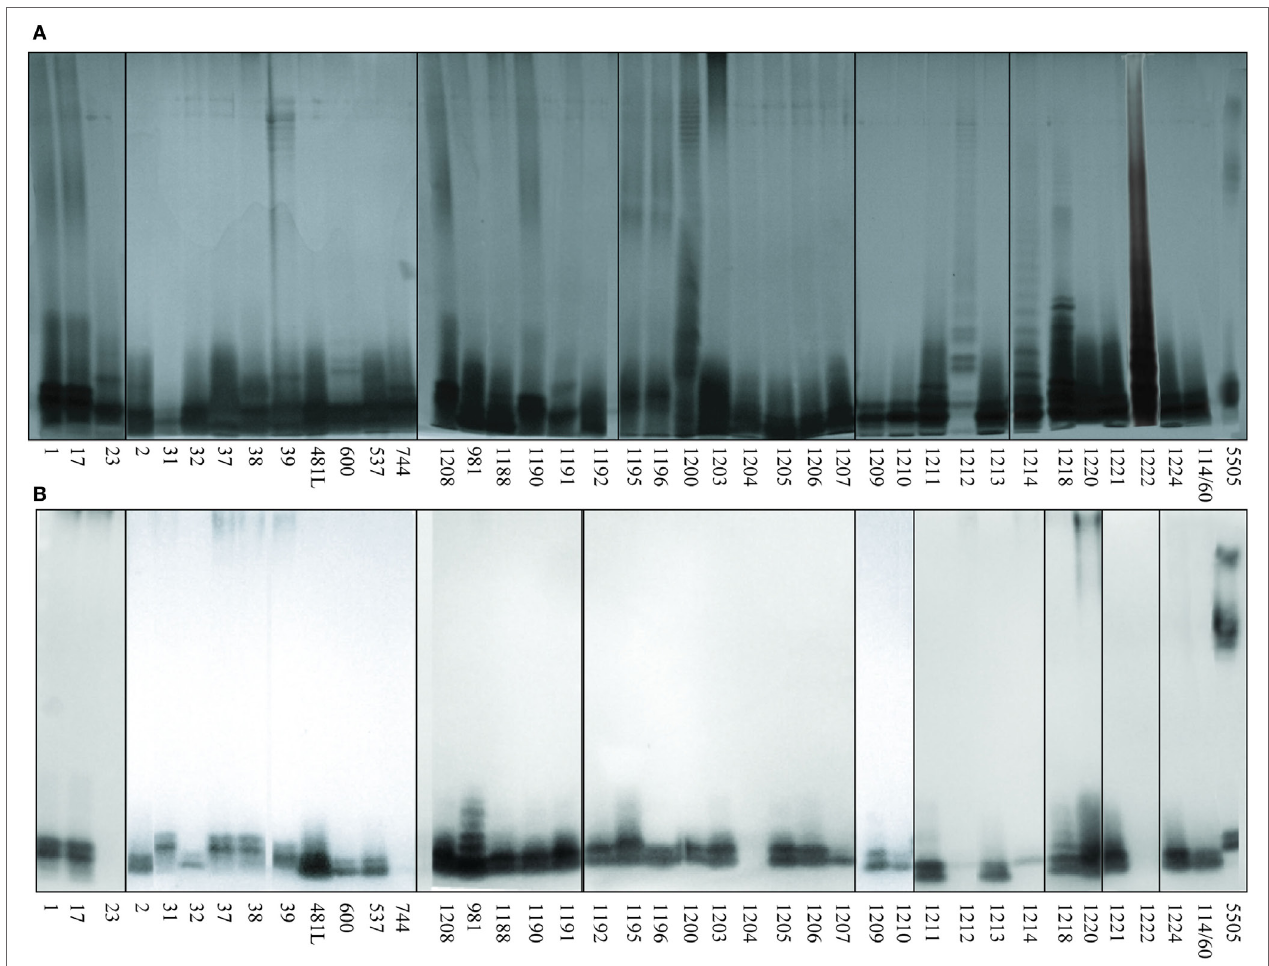
FigUre 2 | Silver stained SDS-PAGE (a) and lectin blotting analysis (B) of the interaction of human MBL (hMBL) with Hafnia alvei lipopolysaccharides (LPSs). Normal human serum (pool) was used as a source of hMBL. Lanes are depicted with the strain number in Polish Collection of Microorganisms. The number 5505 represents Klebsiella pneumoniae O3:K55 − LPS used as a positive